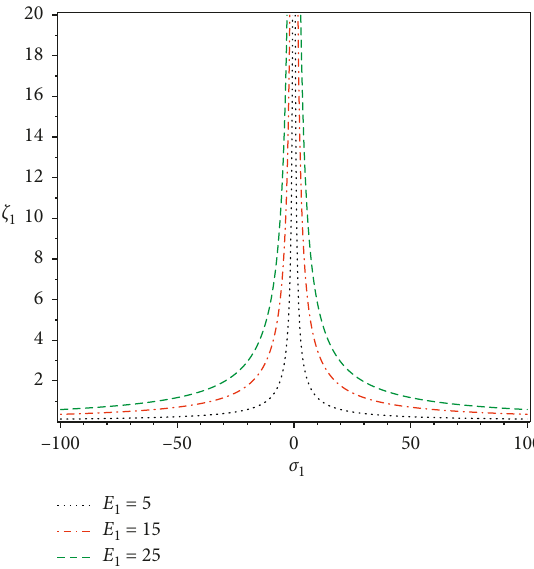
Figure 7: K -volume of macrofibers. Figure